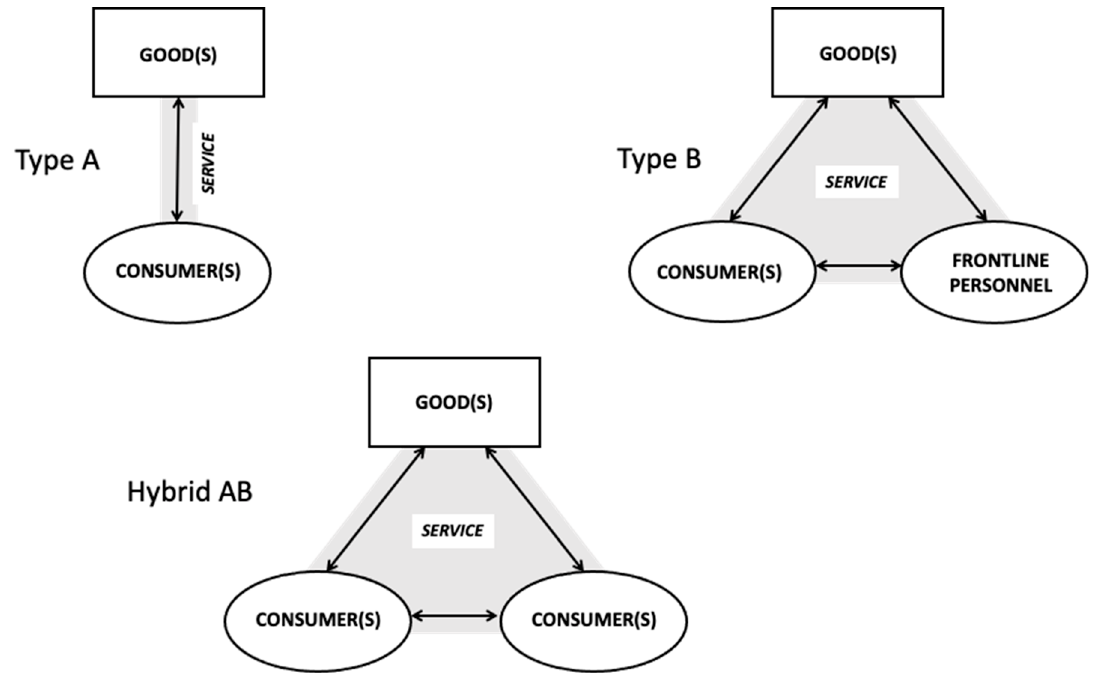
Figure 1. Different consumption